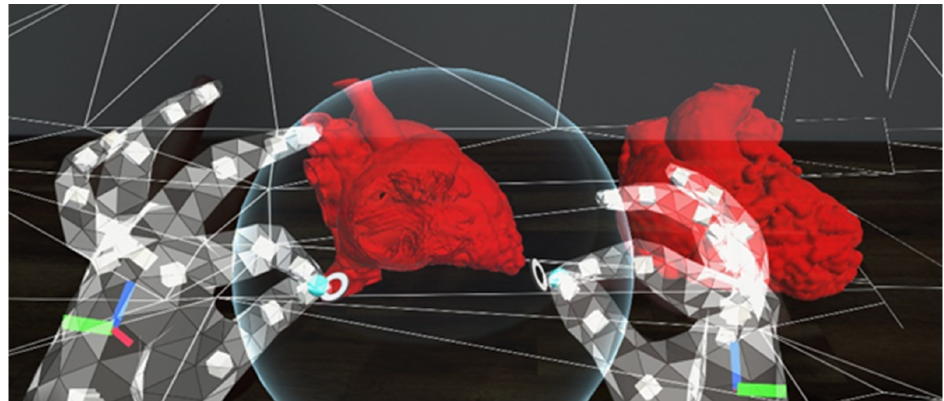
Figure 4. A screenshot using the HoloLens 2. The user is using the sphere to cut through the heart models in order to view the intra ‐ cardiac structures. The sphere can be enlarged or sized down to change the amount of anatomy to be cut out.